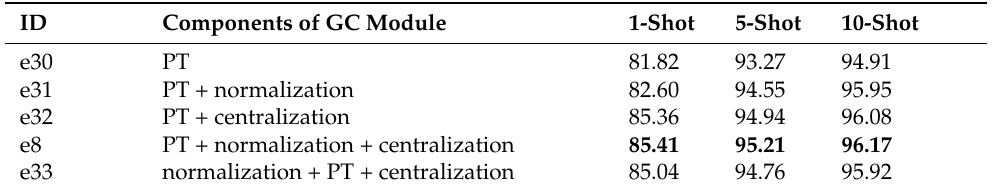
Table 6. The ablation experiments of the GC module. ( f θ : Resnet12; data: setting-2; method: f + GC; filter-size: 8 × 8; channel: top-24).